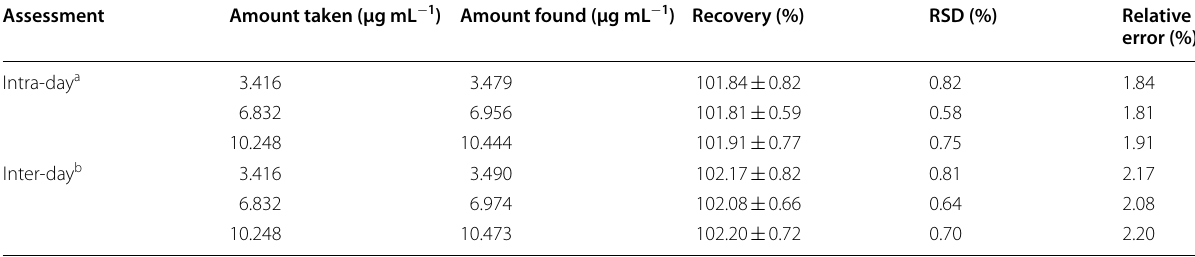
RSD relative standard deviation a Average of six determinations